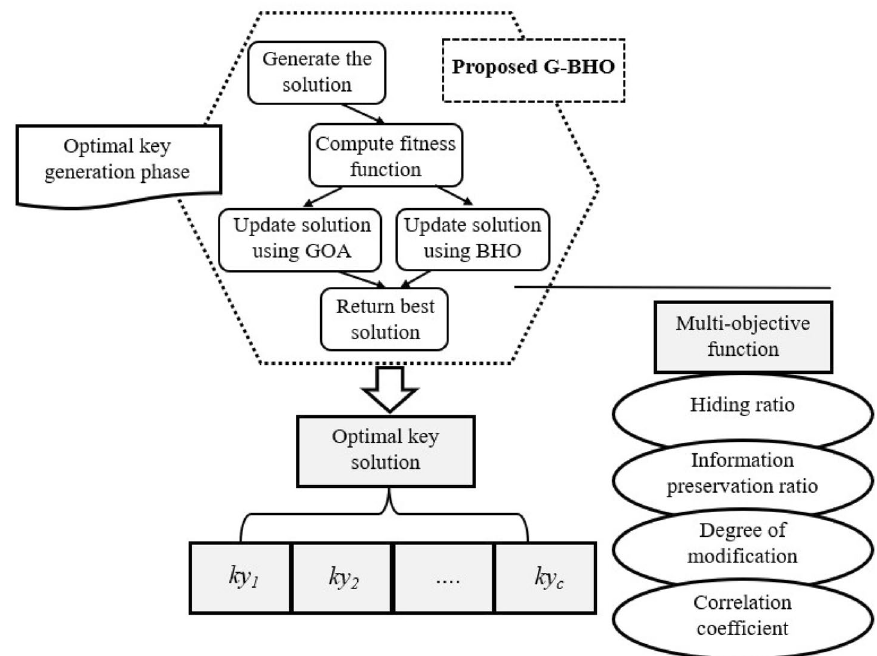
Figure 2. Optimal key generation-based objective function in